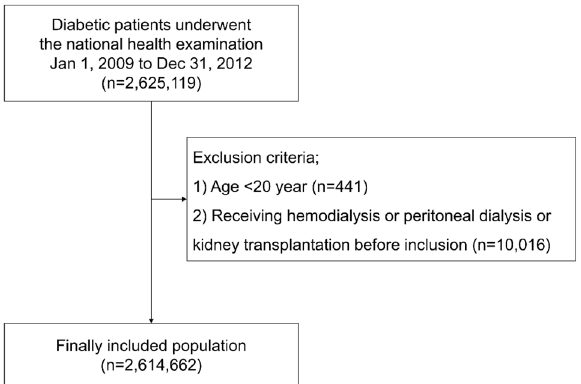
Figure 1. Flow diagram of the